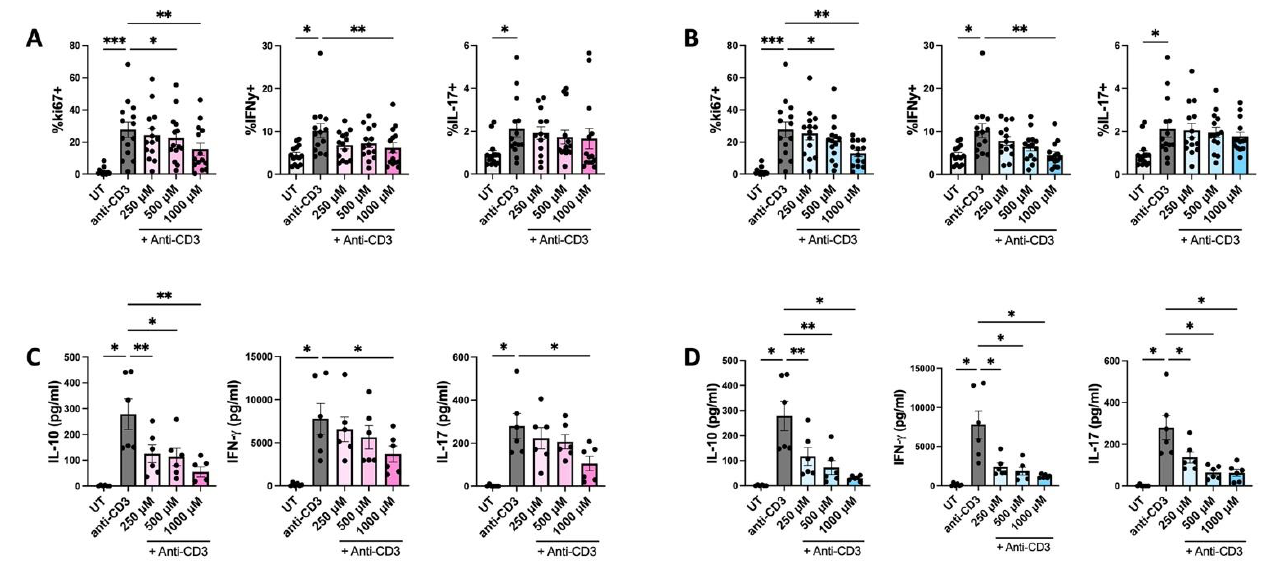
Figure 7. HPP and IP reduce proliferation and cytokine expression in ex vivo stimulated PBMC from patients with Inflammatory Bowel Disease. PBMC isolated from IBD patients were treated with ( A , C ) HPP or ( B , D ) IP (250 µM – 1000 µM) for 6 h prior to stimulation with anti-CD3 for 12 h. After 18 h, culture media was replaced with fresh media and cells were incubated for a further 4 days with anti-CD3 stimulation. Supernatants were removed for analysis of cytokine concentration by ELISA. ( A , B ) Proliferation and cytokine production by CD3 + CD8 − cells was analysed by flow cytometry. Pooled data (N = 14) depicting the mean ± SEM of ki67 (as a measure of proliferation), IFN γ , and IL-17 in CD3 + CD8 − T cells. ( C , D ) Cell supernatants were assessed for concentrations of IL-10, IFN γ , and IL-17 by ELISA. Pooled data depicts mean (±SEM) cytokine concentrations for six IBD patients (means of three technical replicates per donor). Statistical significance was determined by repeated measures one- way ANOVA with Dunnett’s multiple comparisons post hoc test to compare means of treatment groups to the control group (*** p < 0.001, ** p < 0.01, * p < 0.05).